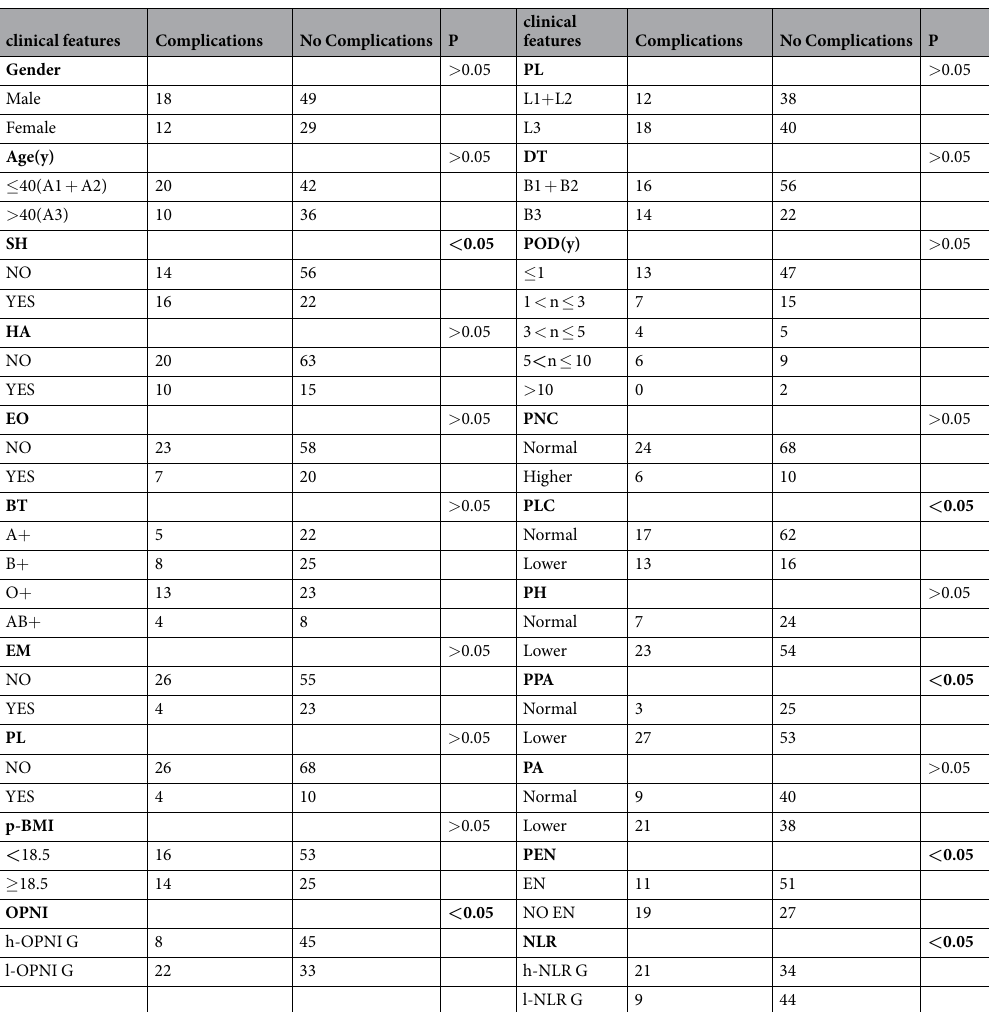
Table 11. Univariate analysis of risk factors for postoperative complications. SH , smoking history; HA , History of appendectomy; EM , extraintestinal manifestations; PL , perianal lesions; p-BMI , preoperative BMI;